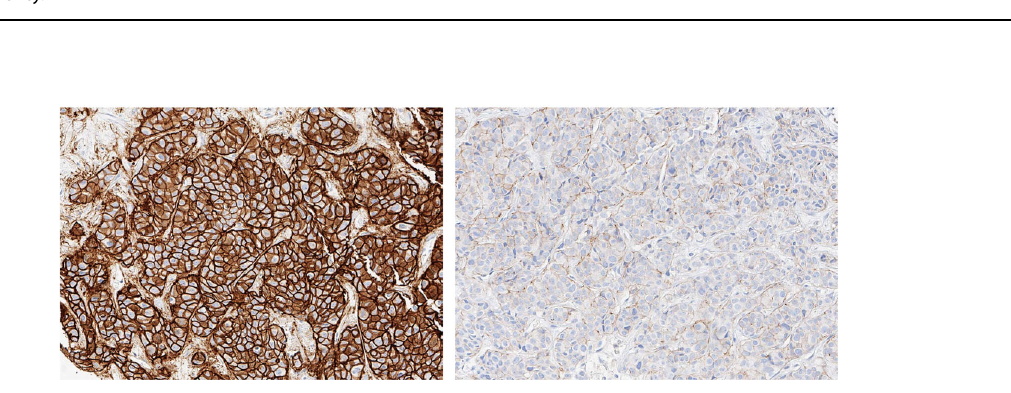
Fig. 2 HER2 immunohistochemistry (IHC) comparison of Study biopsies. Strong HER2 IHC staining in the fi rst hepatic biopsy (Study biopsy #1, left ) and negative HER2 IHC staining in the second hepatic biopsy (Study biopsy #2, right ). Images are shown at ×20 magni fi cation.